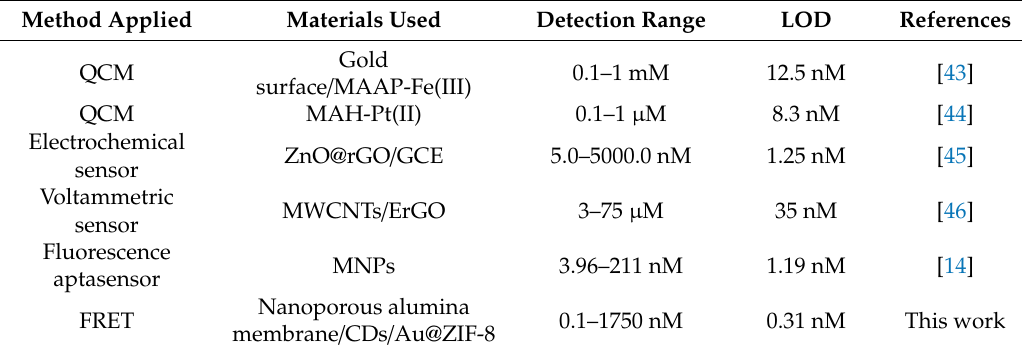
Table 1. A comparison of 8-hydroxy-2 (cid:48) -deoxyguanosine (8-OHdG) detection by the fluorescence resonance energy transfer (FRET) biosensor with various reported